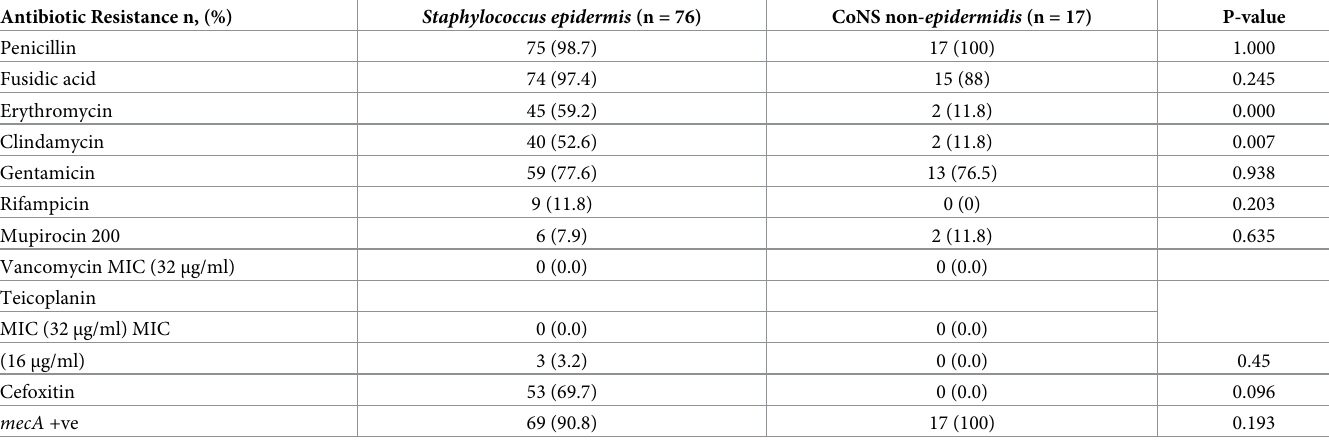
Table 3. Comparison of antibiotic resistance of Staphylococcus epidermis and non-epidermidis blood isolates obtained from neonates. Antibiotic Resistance n, (%)